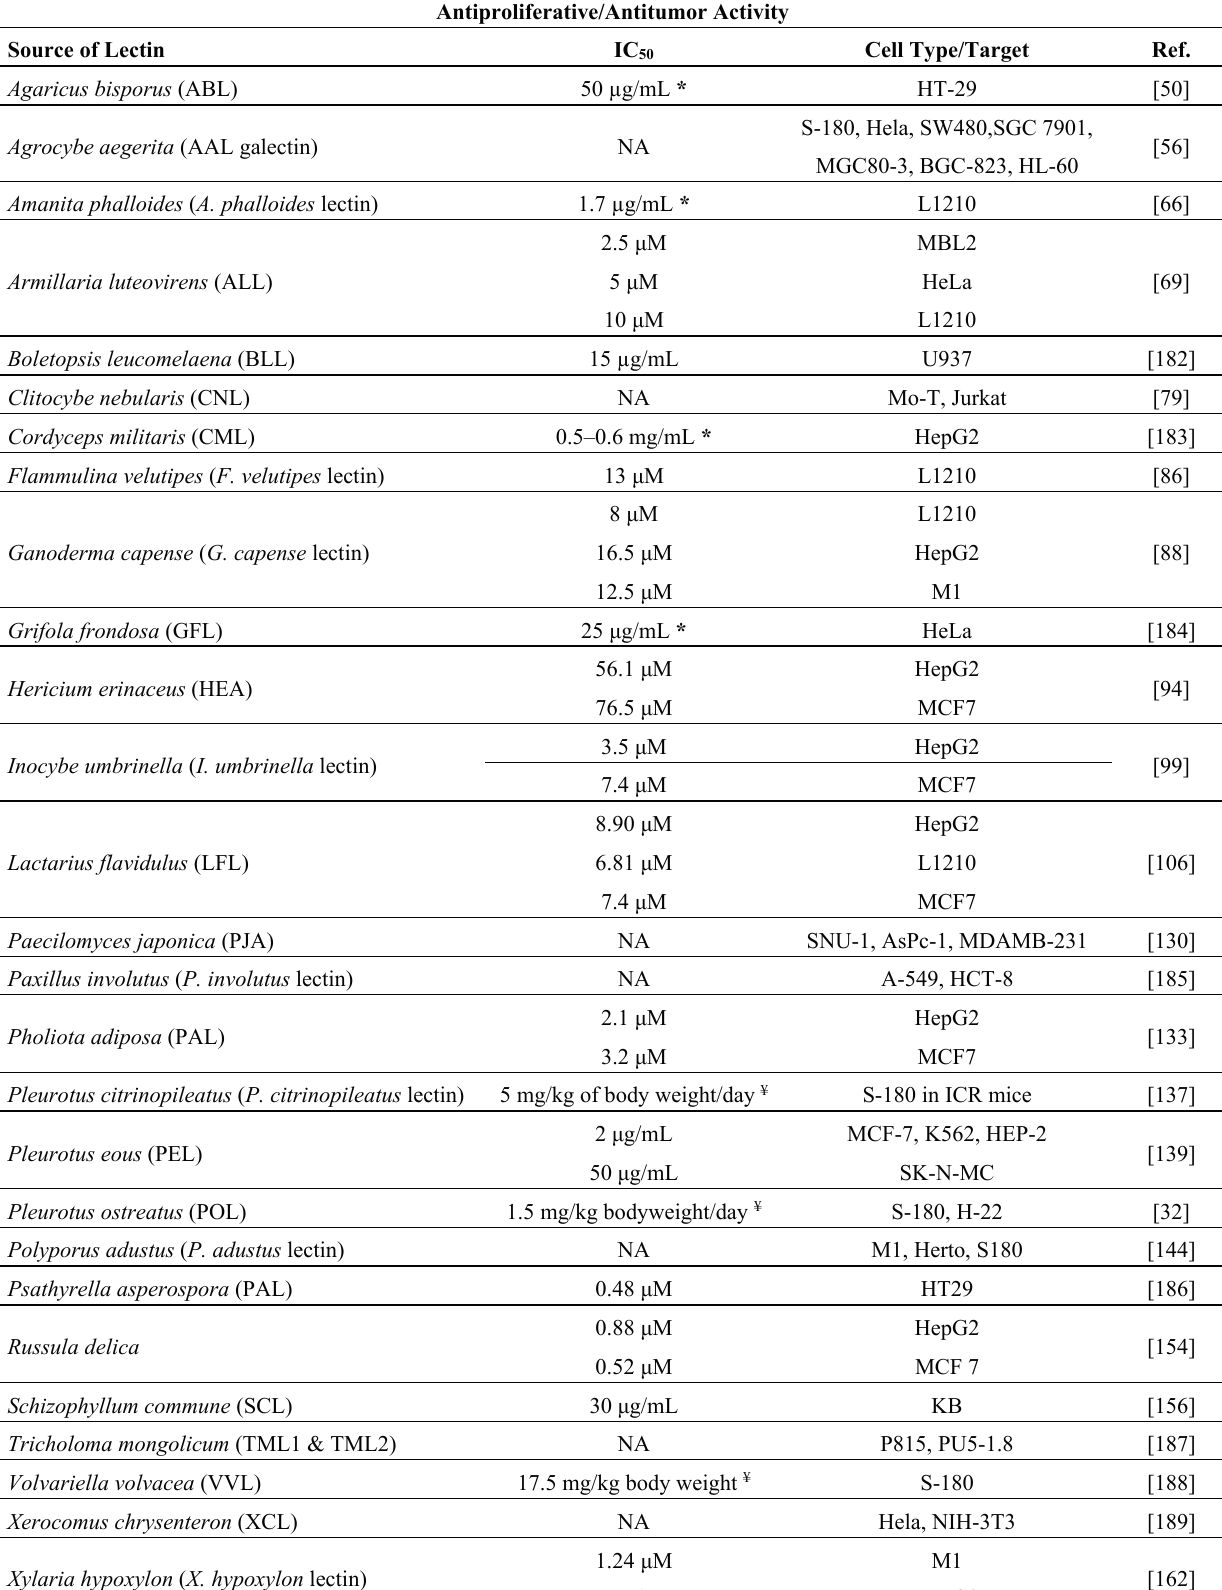
Table 3. Antiproliferative/antitumor and mitogenic activity of mushroom